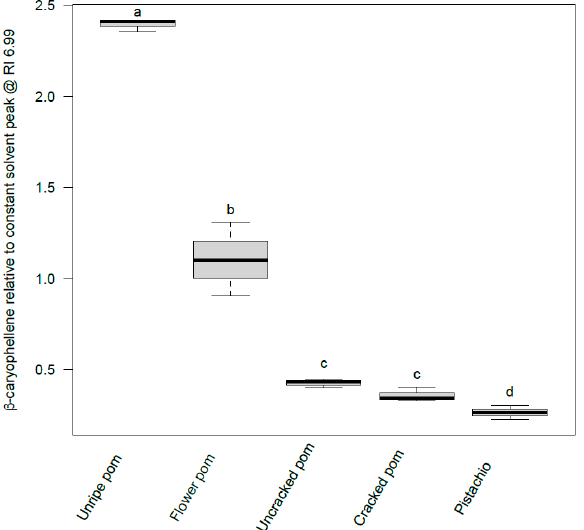
Figure 1. Amounts of β -caryophyllene in the headspace extracts of pomegranate and pistachio fruits and flowers relative to the constant peak in the solvent (retention time: 6.99). Plant materials with different letters are significantly different. Three samples were analyzed per plant sample.